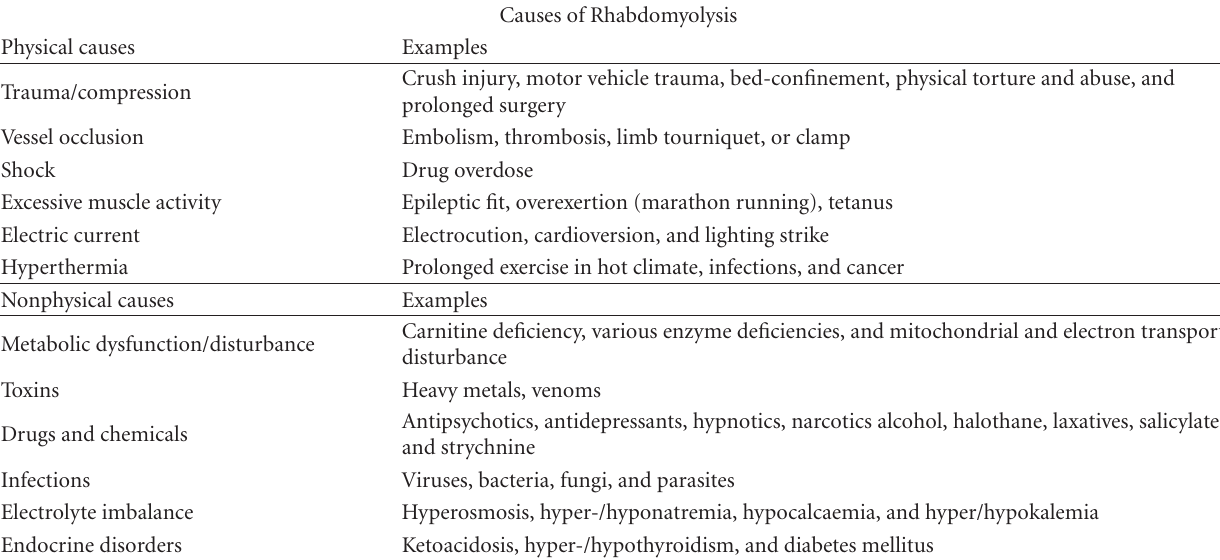
Table 1: Some conditions causing or contributing to rhabdomyolysis adapted from Huerta-Alard´ın et al. with permission from BioMed